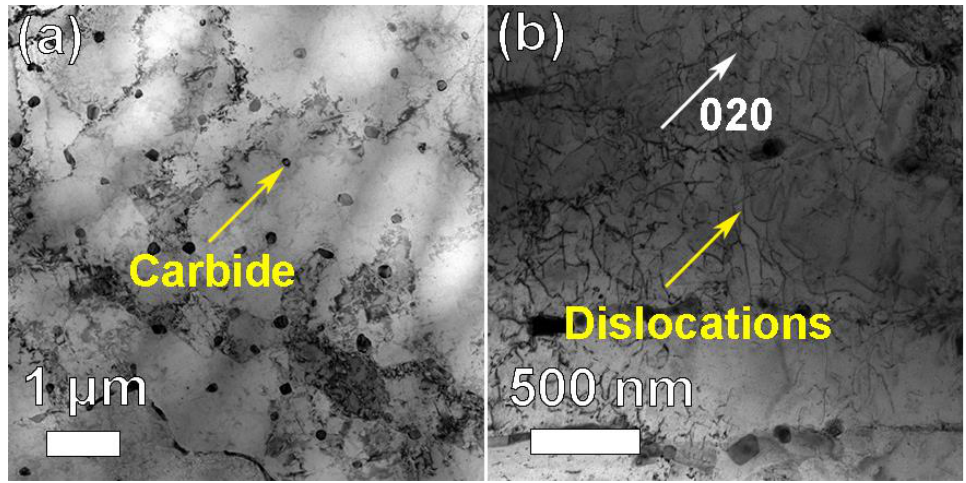
Figure 8. The TEM images of the CRHA. ( a ) bright-field image of the CRHA, ( b ) double weak-beams dark-field image of the CRHA.